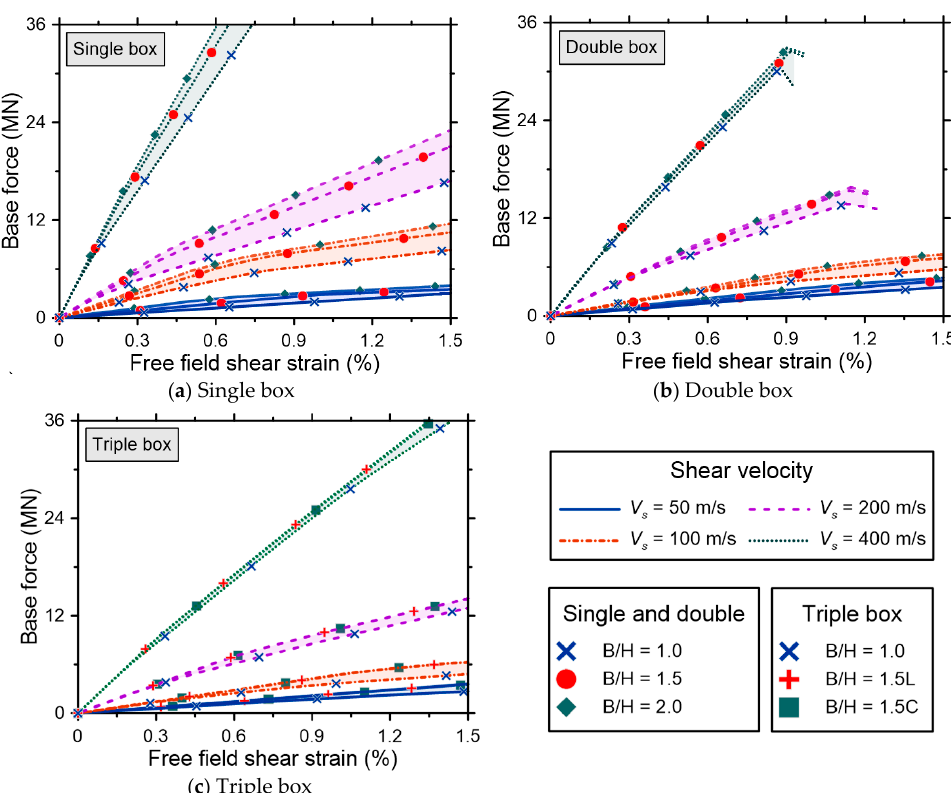
Figure 7. Capacity curves of single box tunnels with different B/H ratios and soil types.